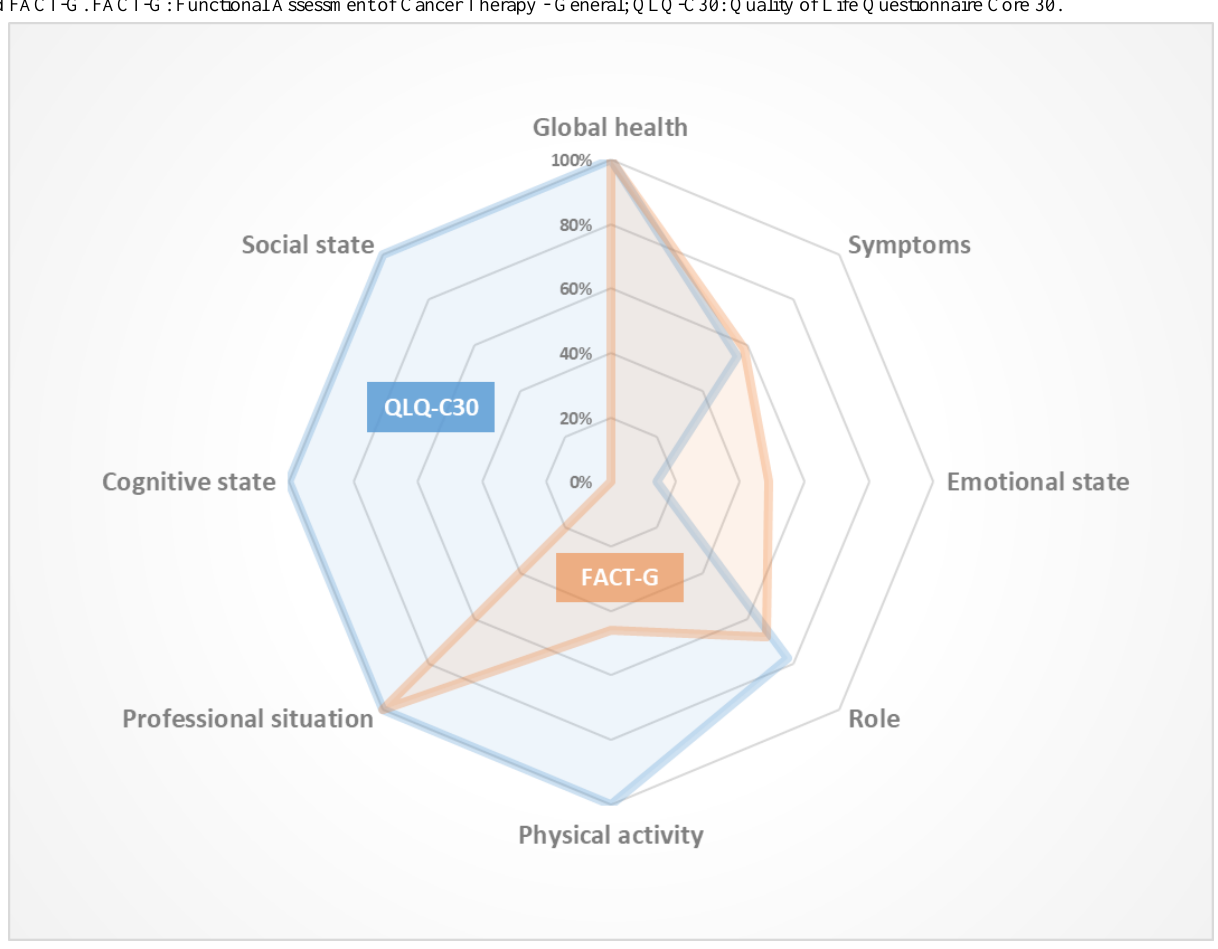
Figure 3. Diagram indicating the coverage rates of each HRQoL domains retrieved in social media by the standard questionnaires EORTC QLQ-C30 and FACT-G. FACT-G: Functional Assessment of Cancer Therapy - General; QLQ-C30: Quality of Life Questionnaire Core